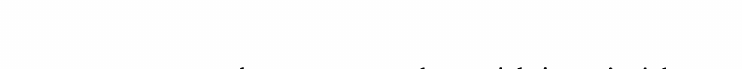
Table 4. Factors Affecting C: Main Effects